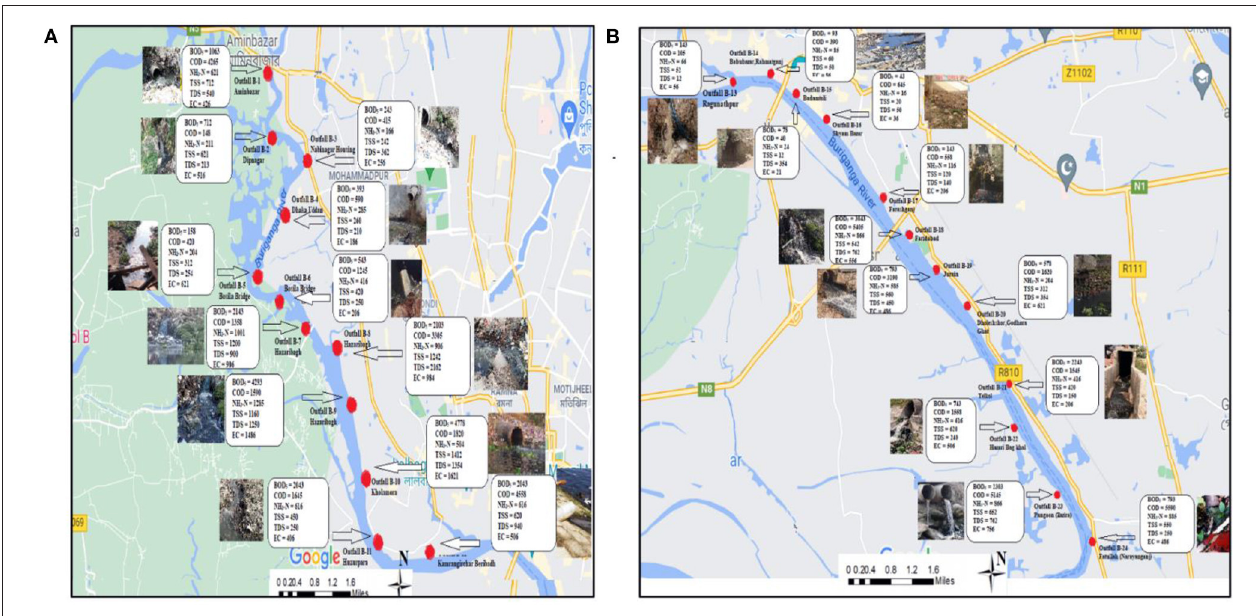
FIGURE 9 | (A,B) Waste load contribution in Buriganga River.